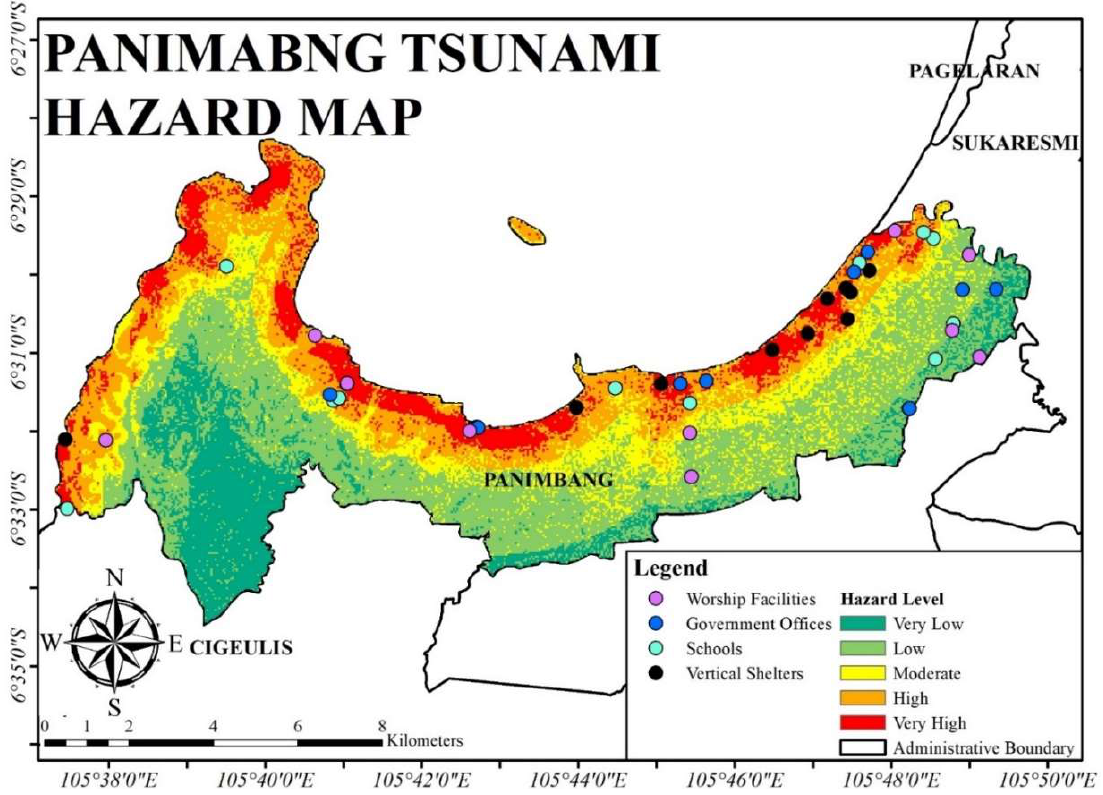
Figure 11. Panimbang tsunami hazard map and proposed locations of evacuation shelters.